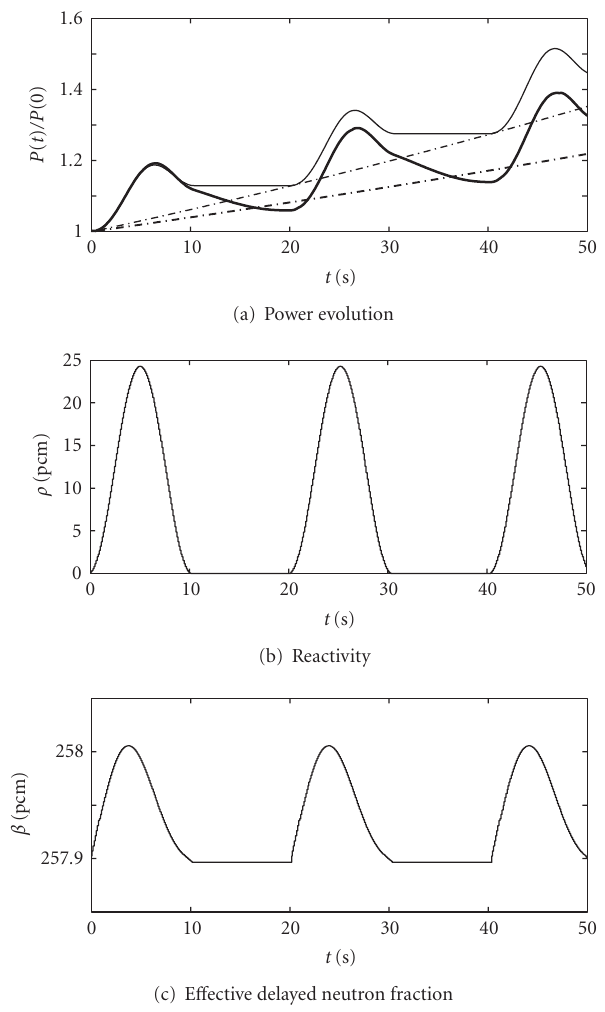
Figure 2: Behavior of total power (a), reactivity (b), and e ff ective delayed neutron fraction (c) for a transient in a critical system in- volving the transit along the reactor axis of a fissile lump. In (a), the point kinetic solution (thin line) and the inversion of the full space-time model (bold line) are reported. Corresponding asymp- totic evolutions (dash-dotted lines) are also presented.